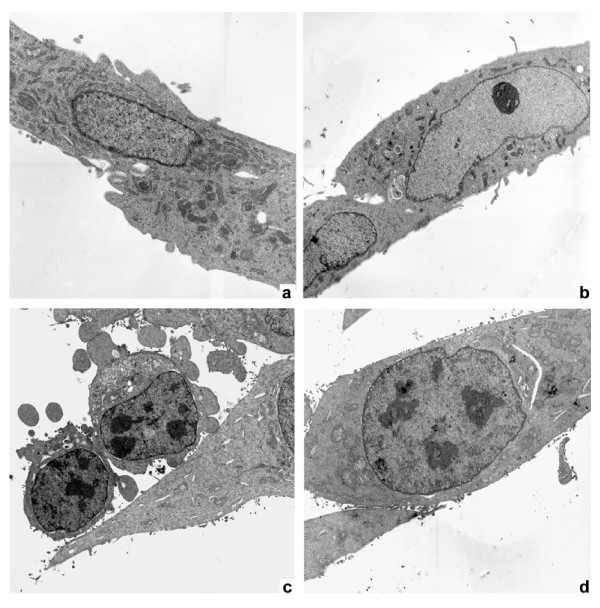
Ultrastructural analysis of astroglial cells. (a) Control cell line. The cells are large with irregular nuclei composed mainly by euchromatin with a few peripheric heterochromatin. Numerous dense mitochondria, endoplasmic reticulum are shown in the cytoplasm (original magnification, ×3800). (b) Incubation of astroglial cells with NAC did not modify ultrastructural images of astroglial cells (original magnification, ×3800). (c) Astroglial cells exposed to HIV-1 undergo apoptotic cell death 3 days after exposure. In fact, the cells displayed an increase of plasma-membrane protrusions and cytoplasmic blabbing and large vacuoles as a result of cytoplasmic loss. The chromatin is condensed and marginalized, expressing DNA fragmentation (original magnification, ×3800). (d) The effect of HIV on astroglial cells is strongly antagonized by coincubation with NAC. In particular, it is shown that cells maintain the normal architecture and the normal ratio between cytoplasm and nuclei, which appear almost completely normal (original magnification, ×3800).